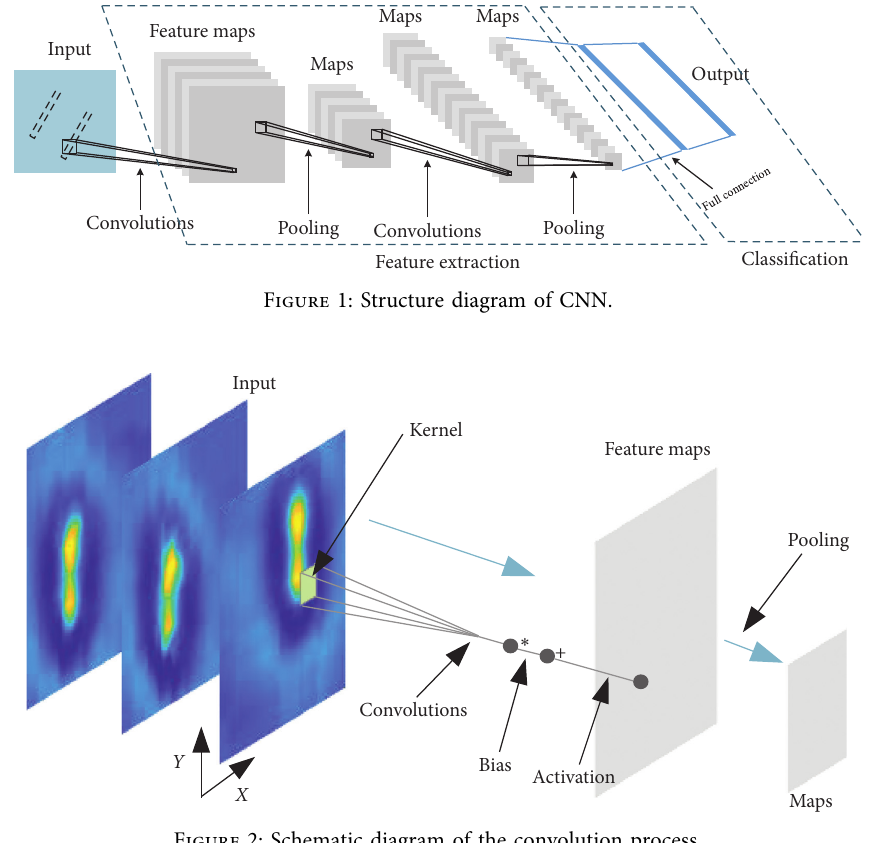
Figure 2: Schematic diagram of the convolution process.